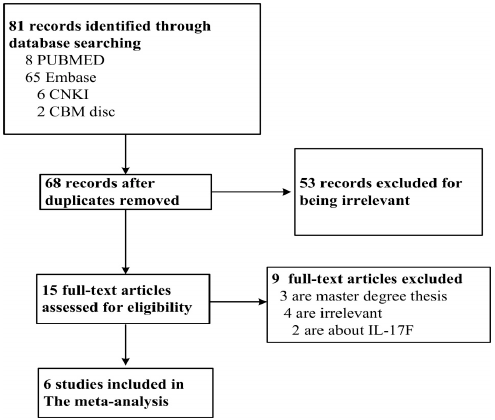
Figure 1. PRISMA flowchart of study inclusion and exclusion.